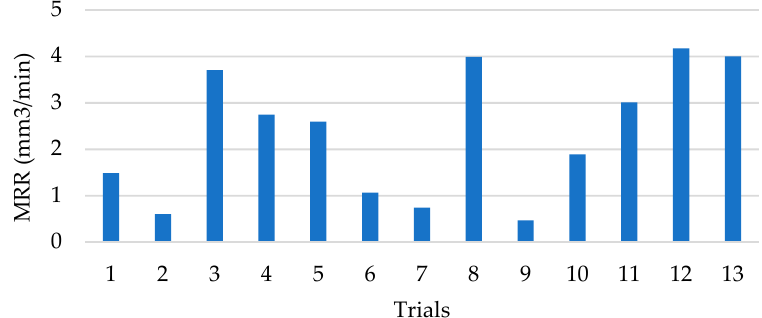
Figure 11. Measured material removal rate values for the developed tests.